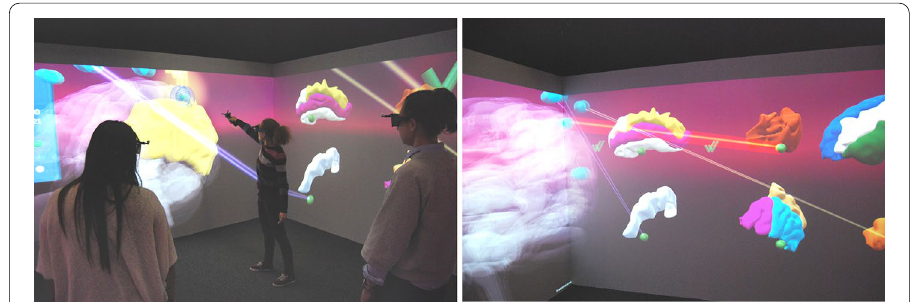
Fig. 1 Left: Scene of collaborative learning with a user highlighting an individual part of the whole brain presented on the main wall of the CAVE. Right: Hand-drawn connections between individual brain areas (right) and their spatial position within the whole brain (left). Green tick marks and red lines indicate VLE feedback on right and wrong